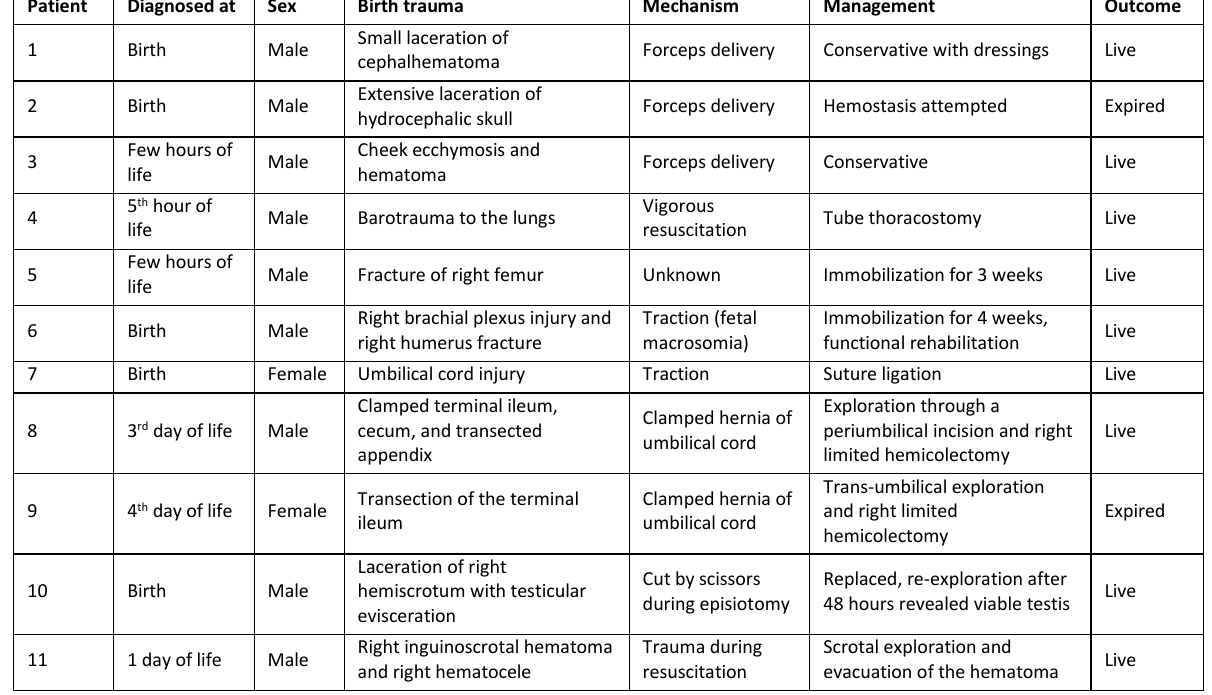
Table 1: Showing a summary of the study